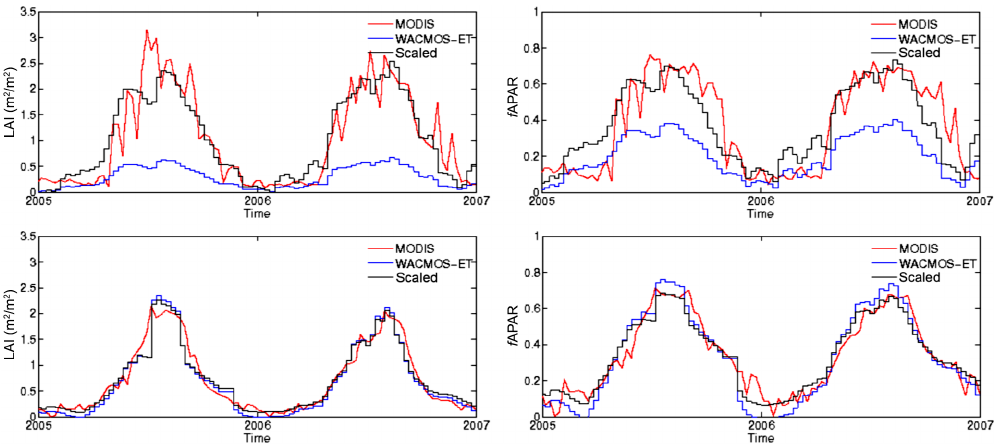
Figure 1. Time series for 2005–2006 of MODIS MOD15A2 LAI and f APAR, WACMOS-ET LAI and f APAR, and the MODIS-like LAI and f APAR (referred to as “scaled” in the figures) at the tower stations CA-Qfo (top panels) and US-Bkg (bottom panels).